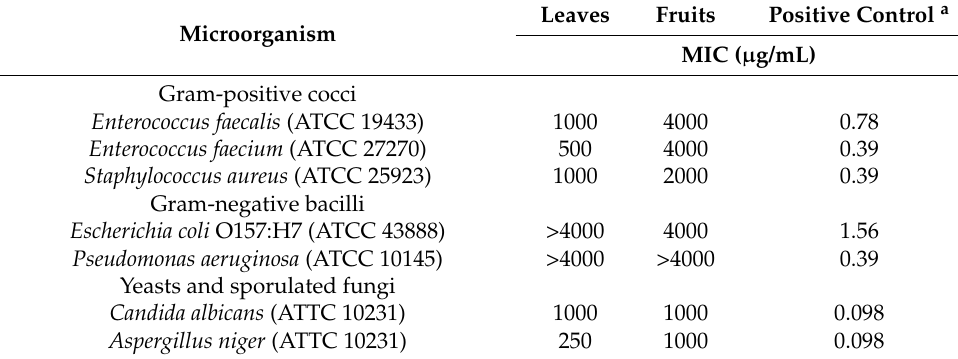
Table 3. Antimicrobial activity of essential oil from the leaves and fruits of Siparuna muricata.